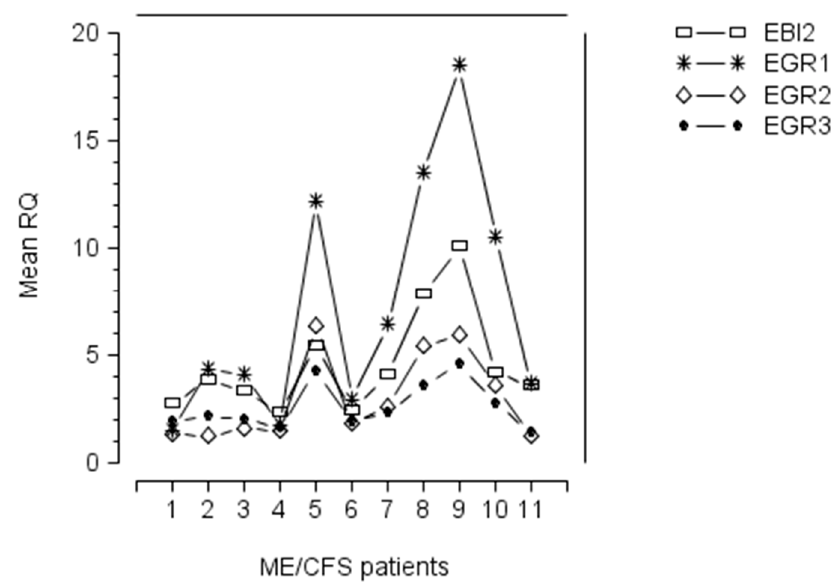
Figure 1. Expression of Epstein–Barr virus (EBV) induced gene 2 (EBI2) (open rectangle), early growth response gene 1 (EGR1) (cross symbol), early growth response gene 2 (EGR2) (open diamond), and early growth response gene 3 (EGR3) (solid circle) mRNAs in peripheral blood mononuclear cells (PBMC) of 11 myalgic encephalomyelitis/chronic fatigue syndrome (ME/CFS) patients with